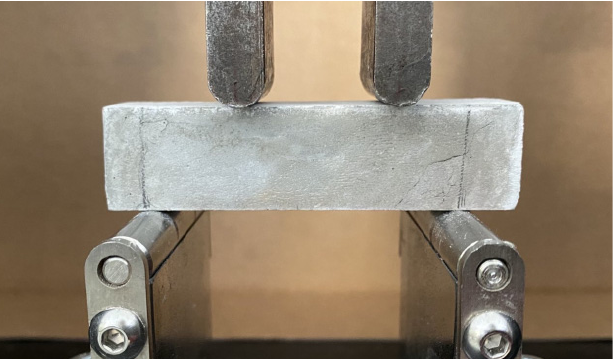
Figure 6. 4-point bending test experimental set up.